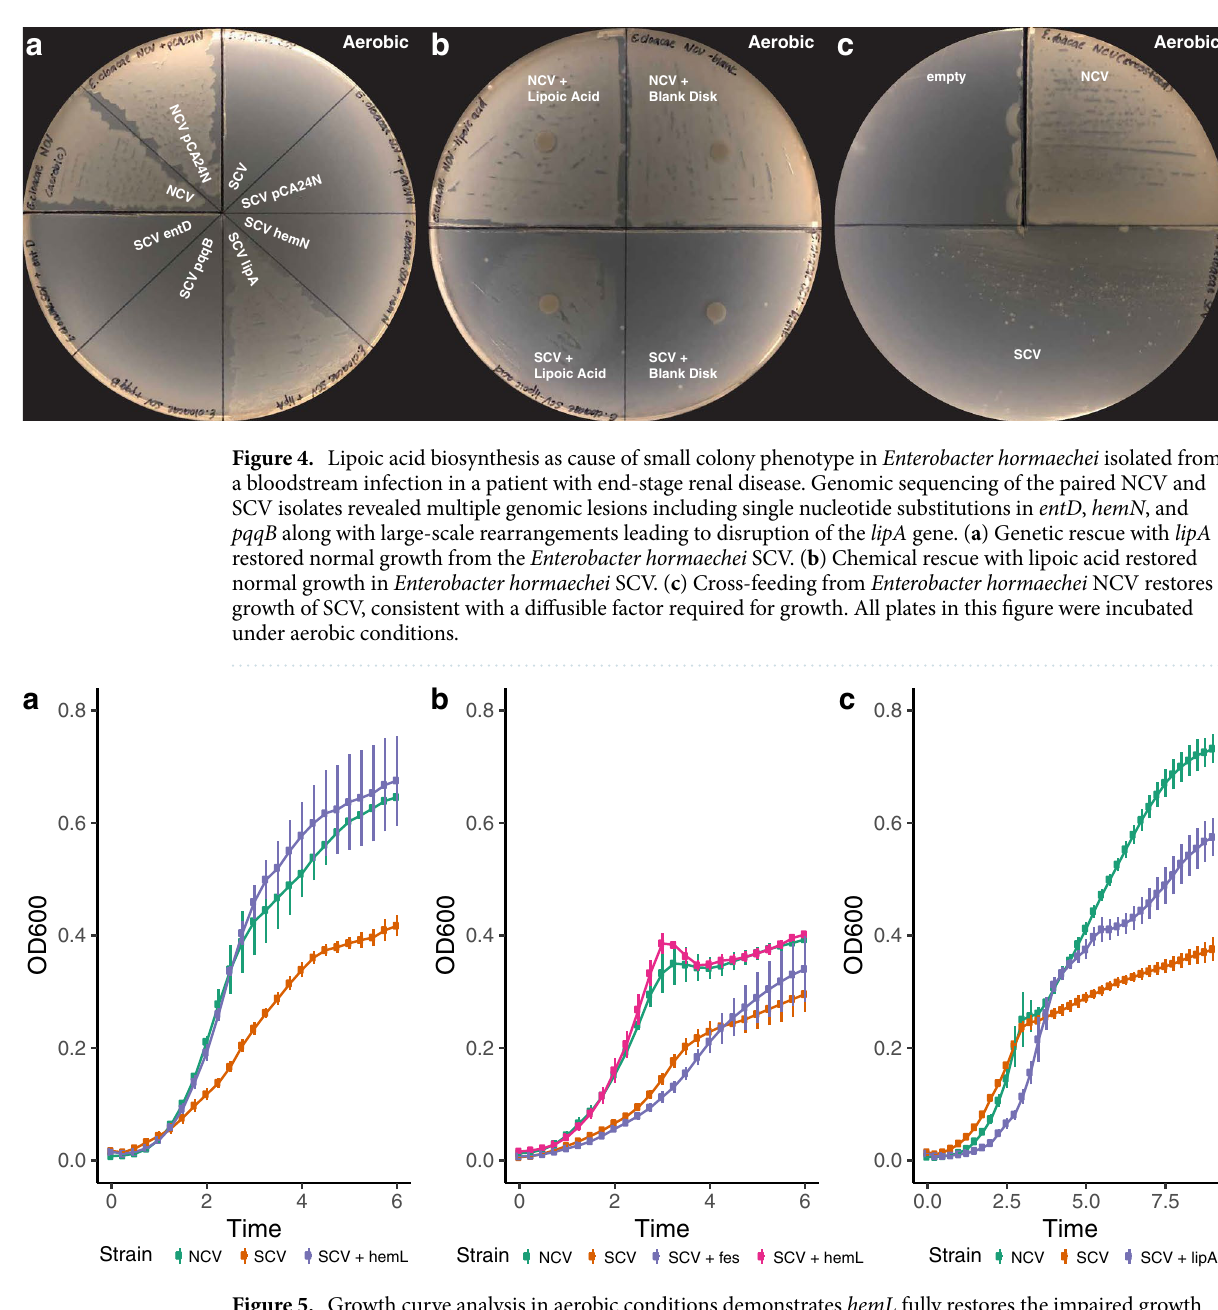
Figure 5. Growth curve analysis in aerobic conditions demonstrates hemL fully restores the impaired growth kinetics of ( a ) Escherichia coli SCV and ( b ) Citrobacter freundii SCV isolates. The Citrobacter freundii SCV isolate was not rescued by fes . ( c ) Growth kinetics of the Enterobacter hormaechei SCV isolate are partially restored by overexpression of lipA